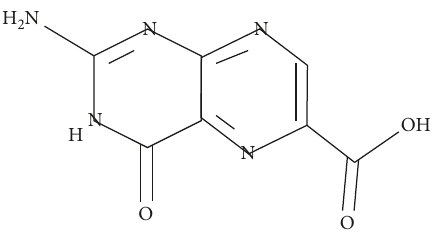
Figure 10: Chemical structure of pterin-6-carboxylic acid.